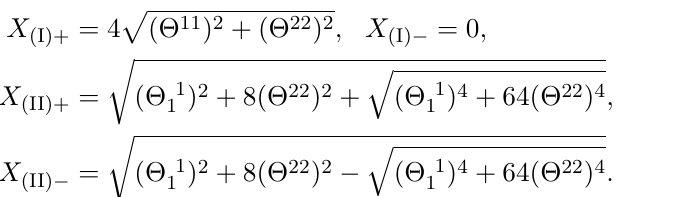
and (cid:2) 22 , between f 0 ; 0 : 1 g 1